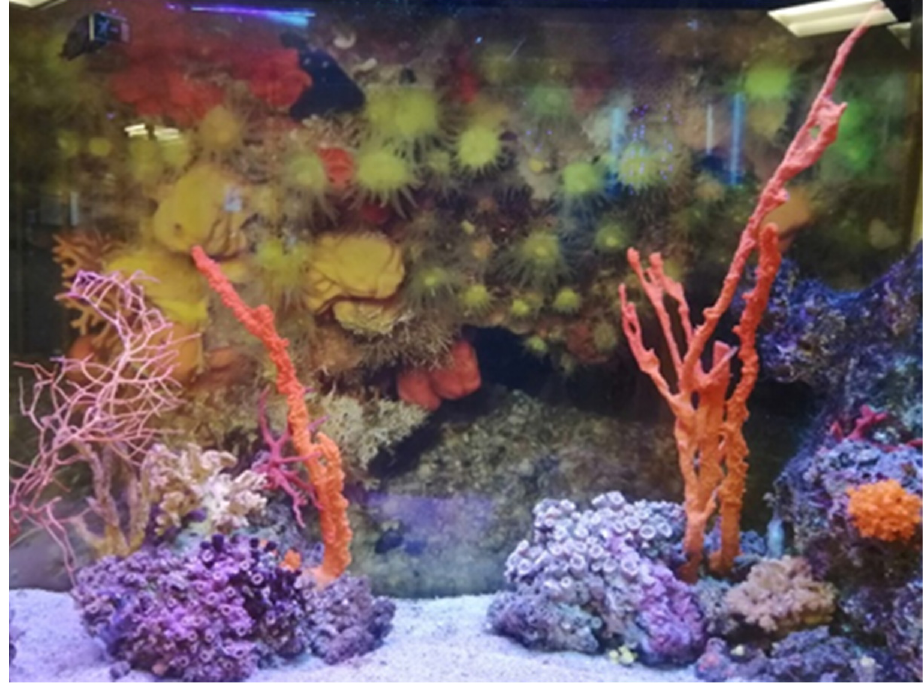
Figure 3. The bright orange and stylized sponge Axinella cannabina as an ornamental aquarium spe-